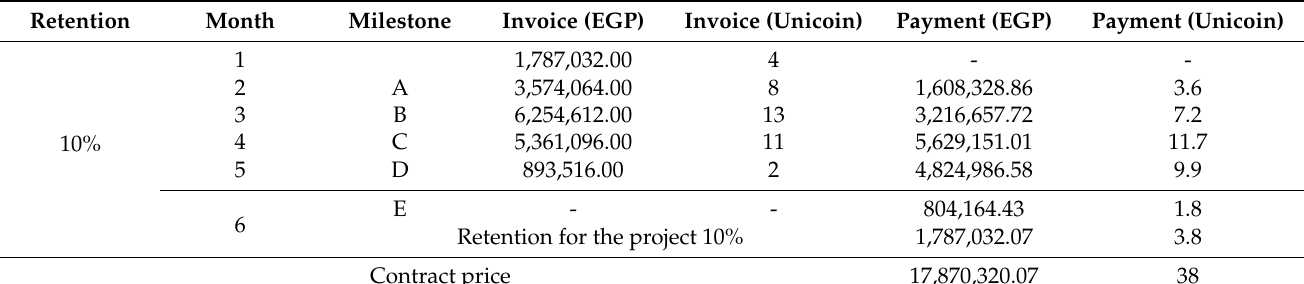
Table 3. Payment and invoice values for each milestone.